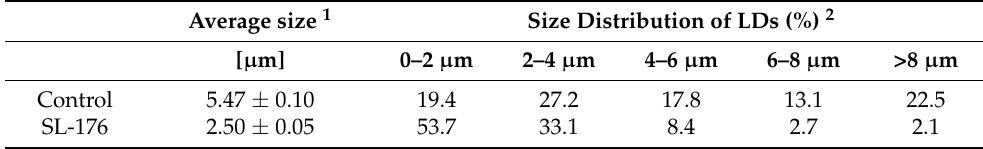
Table 2. The proportions of lipid droplet (LD) sizes in mature 3T3-L1 cells treated with